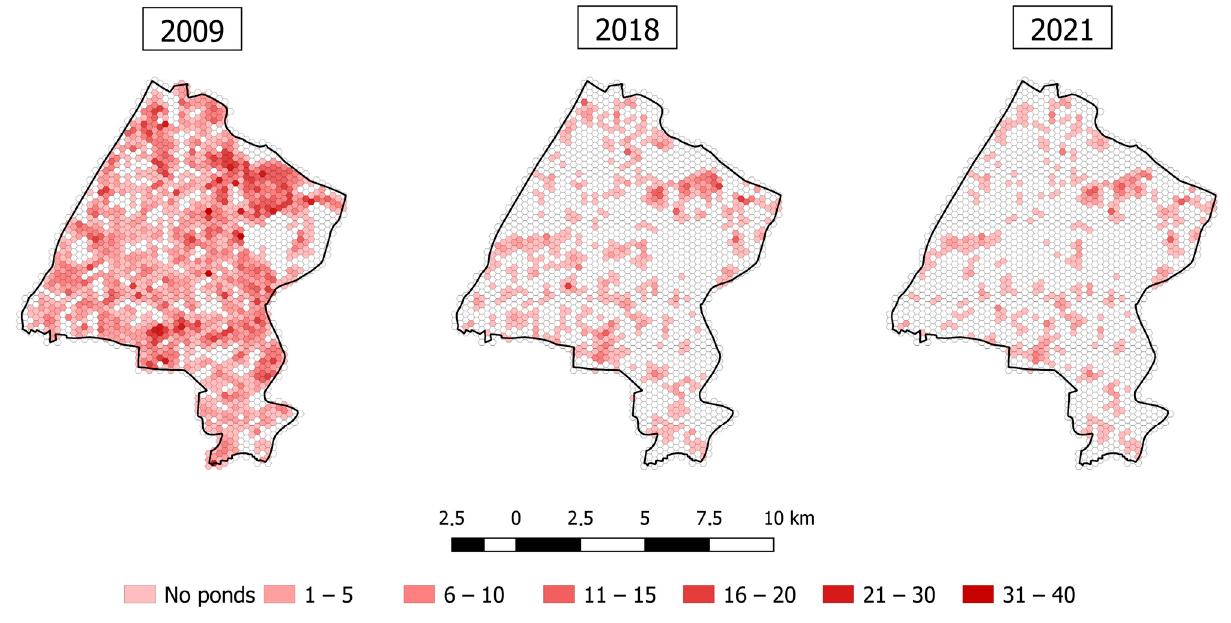
Figure 9. Density maps of the fishponds for the years 2009, 2018, and 2021.